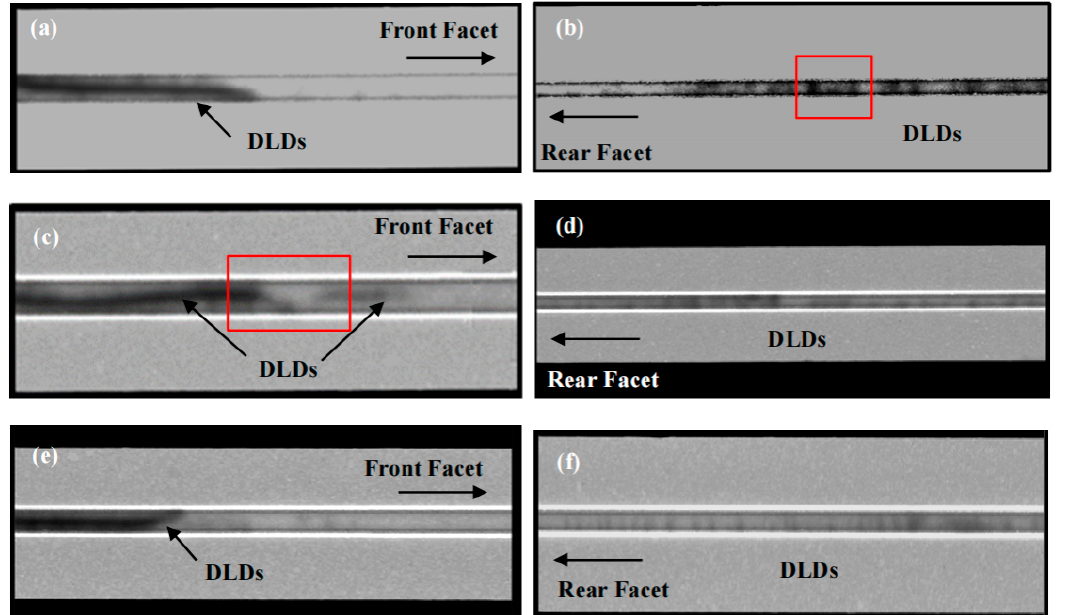
Figure 5. EBIC images were captured from high-power InGaAs/AlGaAs QW lasers with different aging conditions near the front facet. ( a ) 2.1 A/70 ◦ C with a fail time of 10,205 h, ( c ) 1.8 A/70 ◦ C with a fail time of 2560 h, and ( e ) 2.1 A/70 ◦ C with a fail time of 1180 h and corresponding EBIC images near the rear facet ( b , d , f ). Reprinted with permission from ref. [61] © SPIE. Copyright 2018 Proceedings of SPIE.